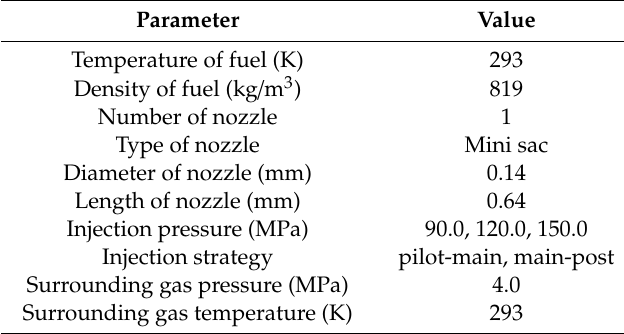
Table 1. Conditions for the injection rate